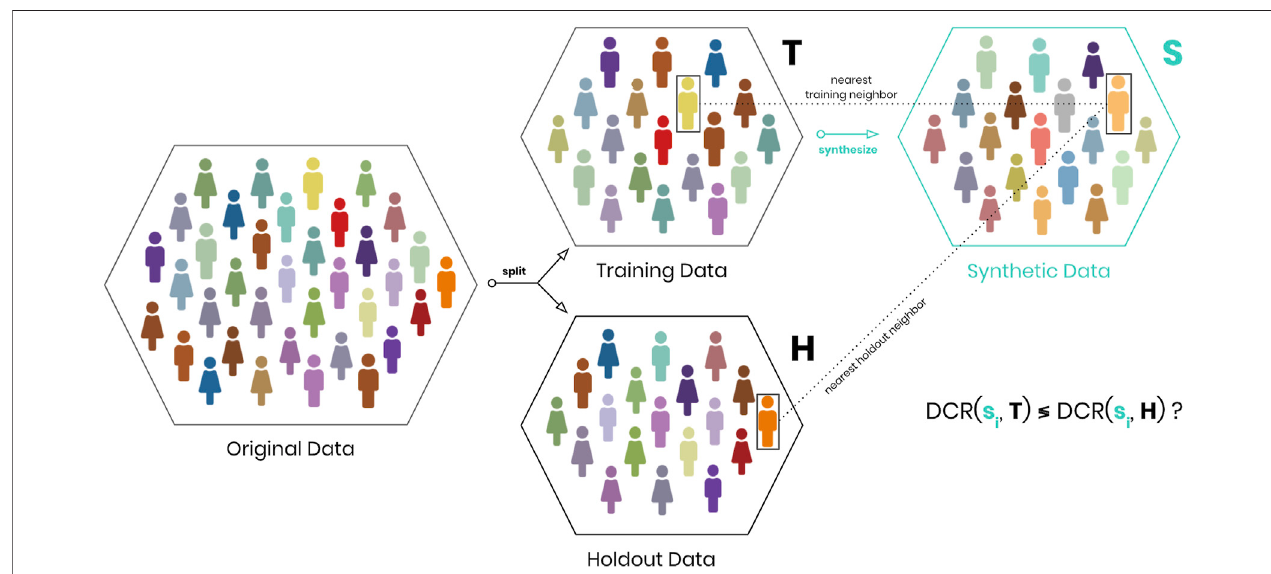
FIGURE5| Constructionoftheholdout-basedprivacyriskmeasure. Foreachsyntheticrecordwedeterminewhetherthenearestneighborwithintrainingdata T is orisnotsmallerthanthenearestneighborwithrespecttoholdoutdata H